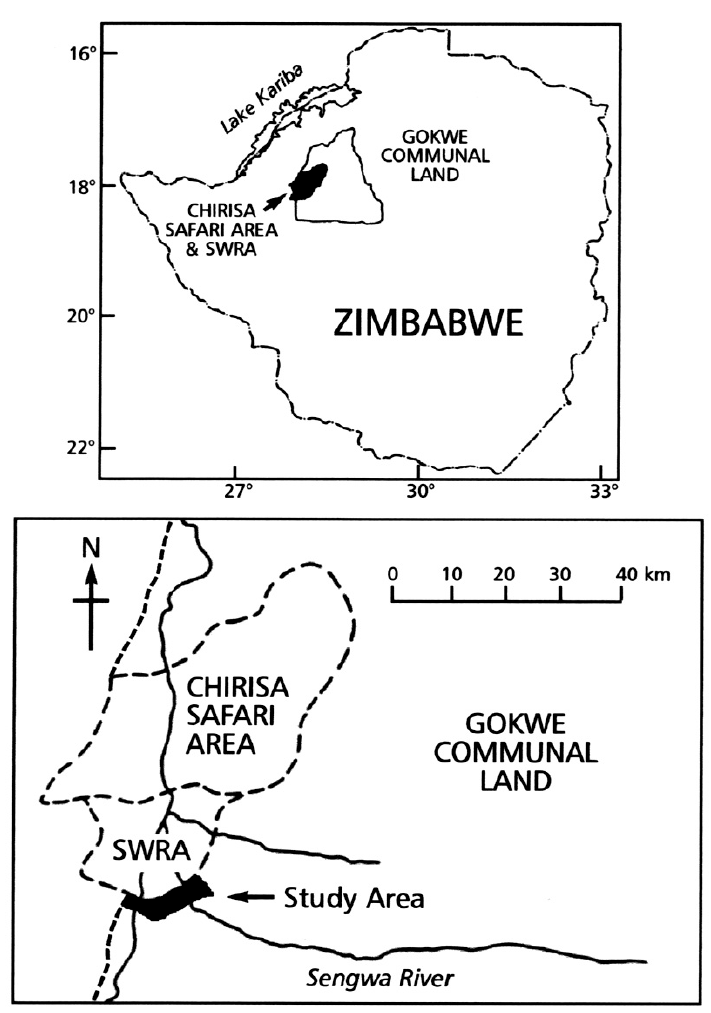
Figure 1. The location of the Gokwe Communal Land study area and the Sengwa Wildlife Research Area (SWRA) in northwestern Zimbabwe.